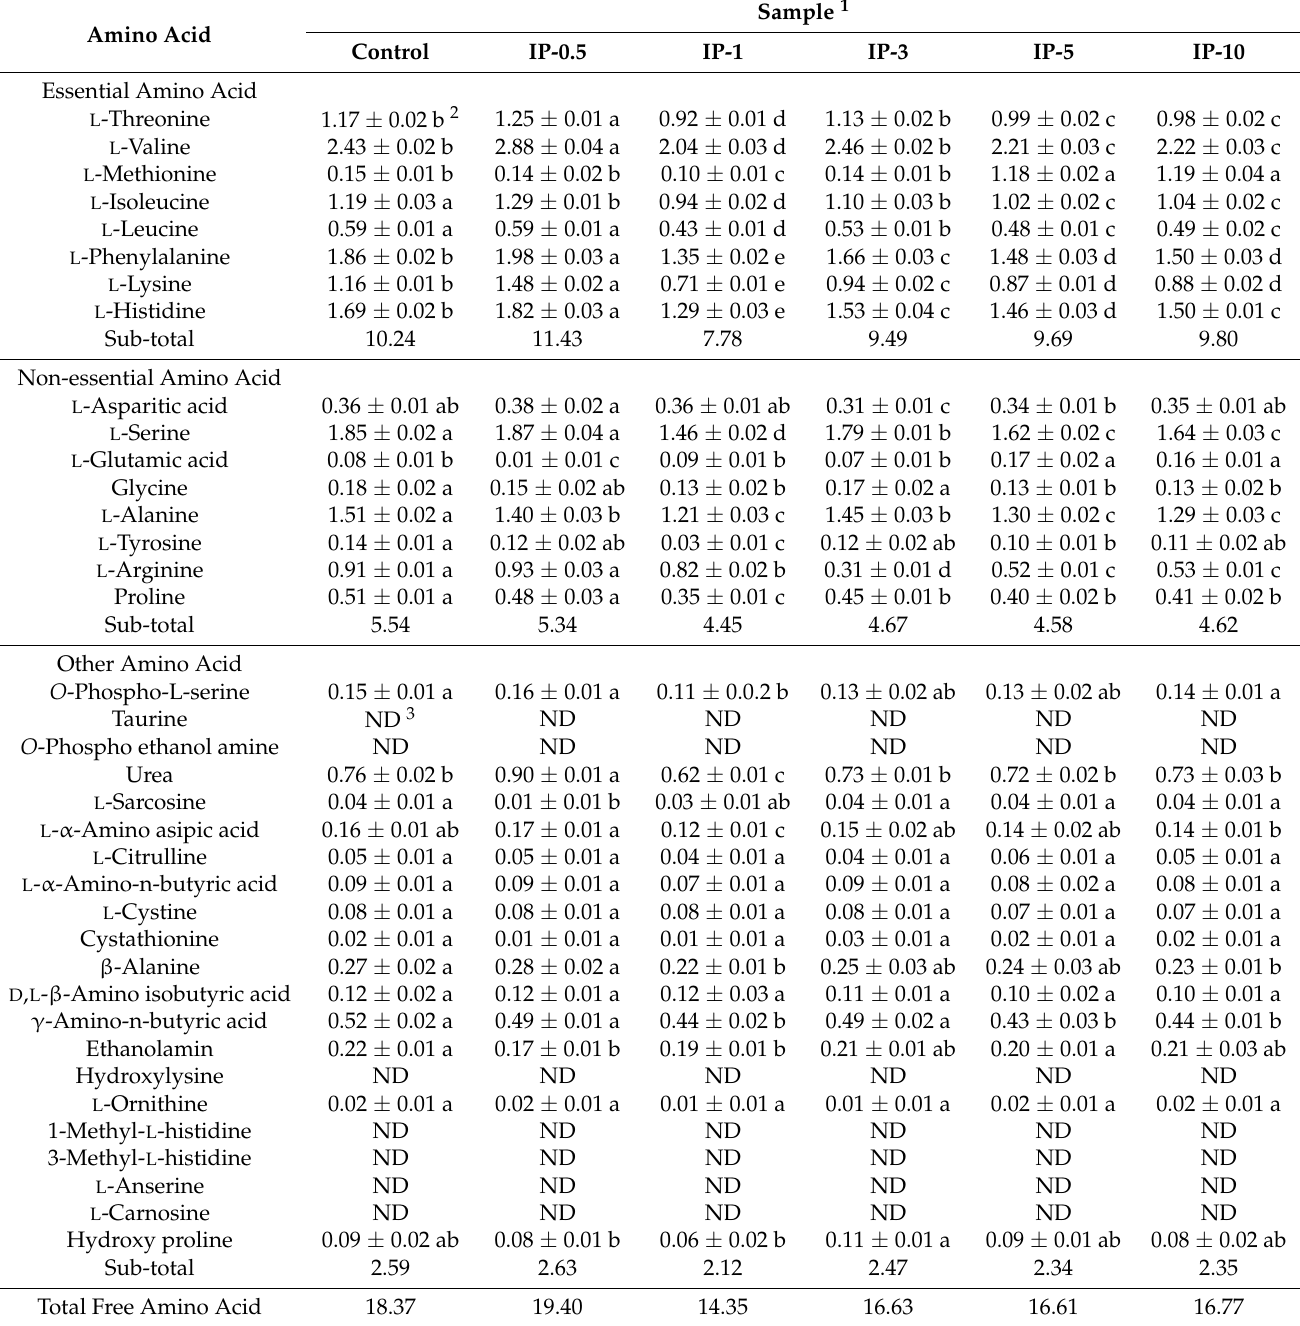
Table 6. Free amino acid composition (mg/g of dry weight) of soybean sprouts cultivated after different concentrations of illite